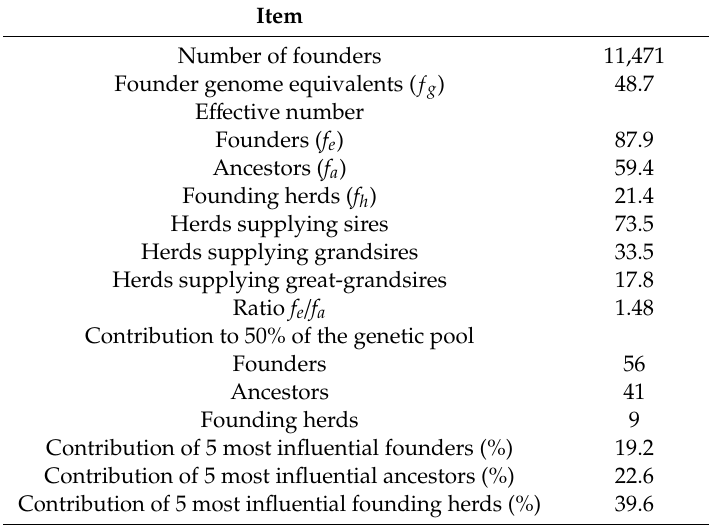
Table 3. Genetic contributions of founders, ancestors and founding herds to the reference population (calves born between 2015 and 2019, n =